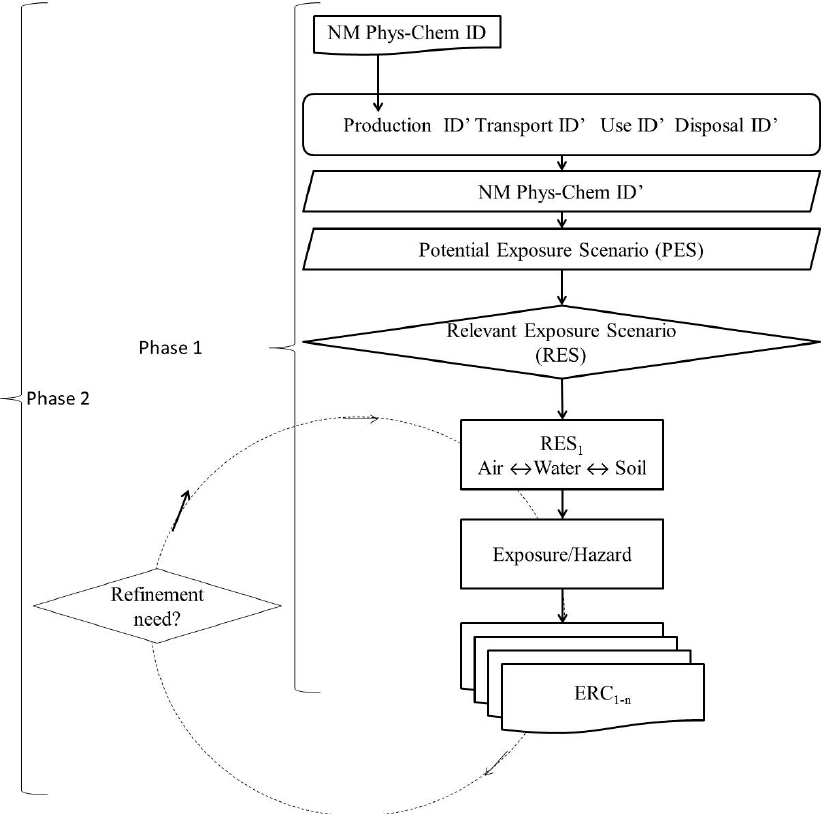
Figure 2. The overall Environmental Risk Assessment (ERA) Strategy.